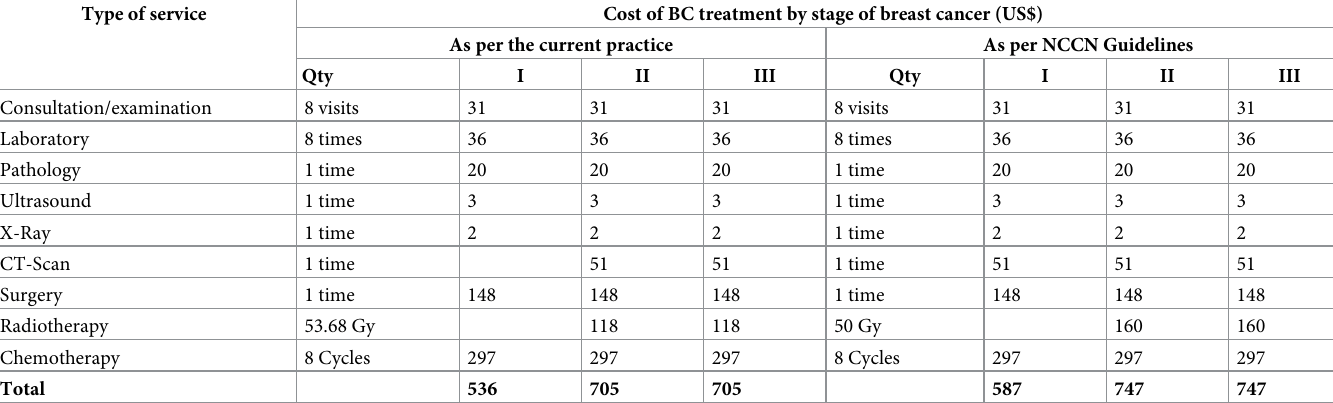
Table 5. Comparison of breast cancer treatment costs between current practice and NCCN guidance (as of April 21, 2020). Type of service